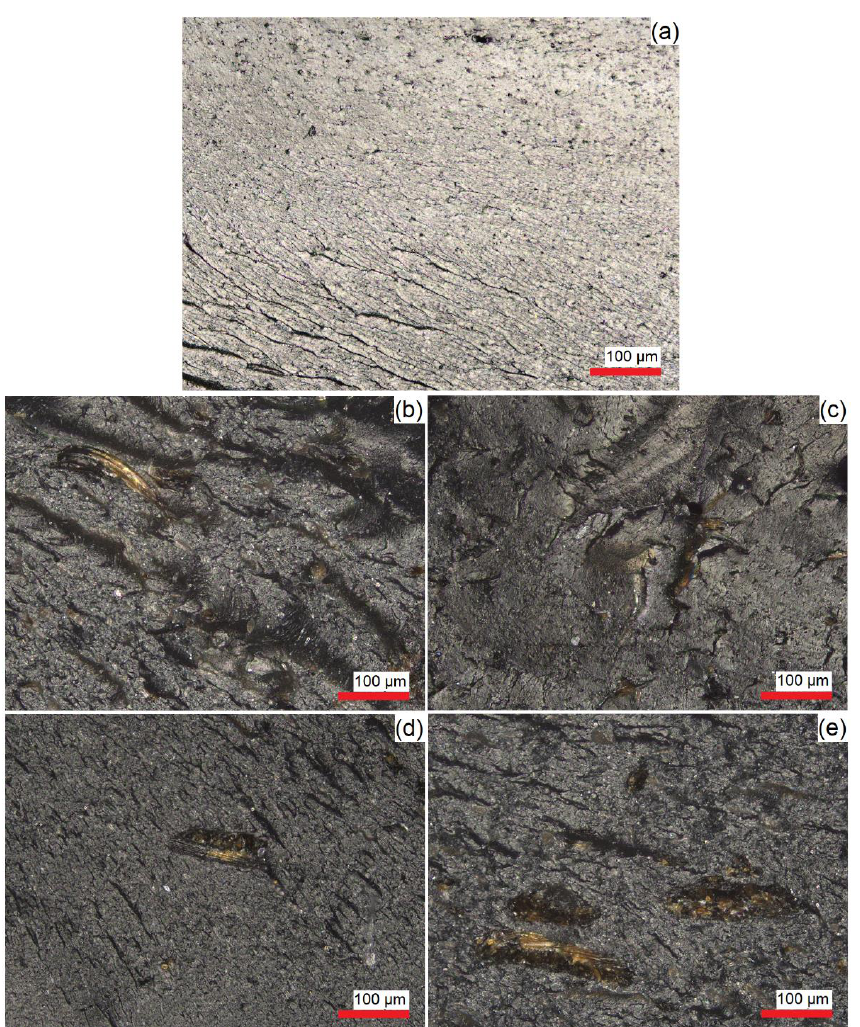
Figure 4. Optical images of cryofractured injection molded samples: ( a ) no biofiller; ( b ) 5% wt. coffee chaff; ( c ) 10% wt. coffee chaff; ( d ) 5% wt. rice hull; ( e ) 10% wt. rice hull.